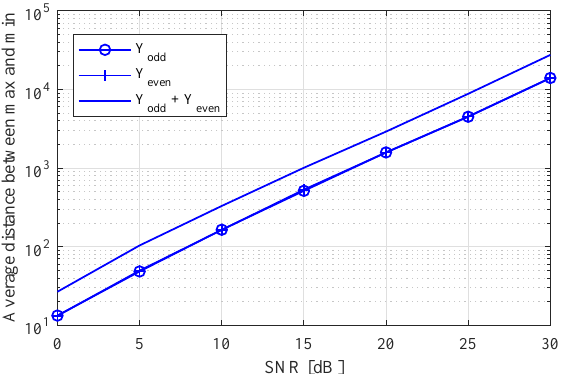
Figure 9. Distance between minimal and maximal values according to signal-to-noise ratio (SNR) with K =